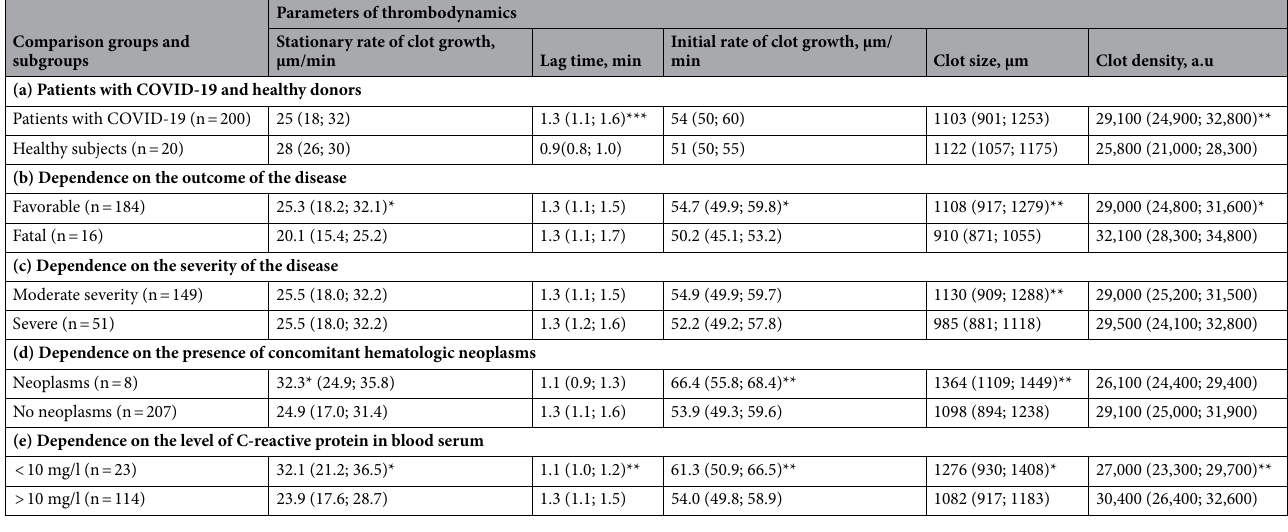
Table 1. Parameters of thrombodynamics in the COVID-19 patients. Results are presented as median and interquartile range (25th and 75th percentiles). *p < 0.05, **p < 0.01, ***p < 0.001; Mann–Whitney U-test.